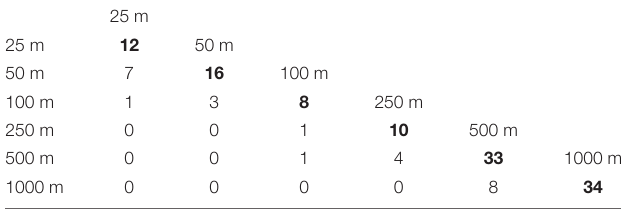
TABLE 2 | Number of species common to particular depths. TABLE 3 | Number of species common to